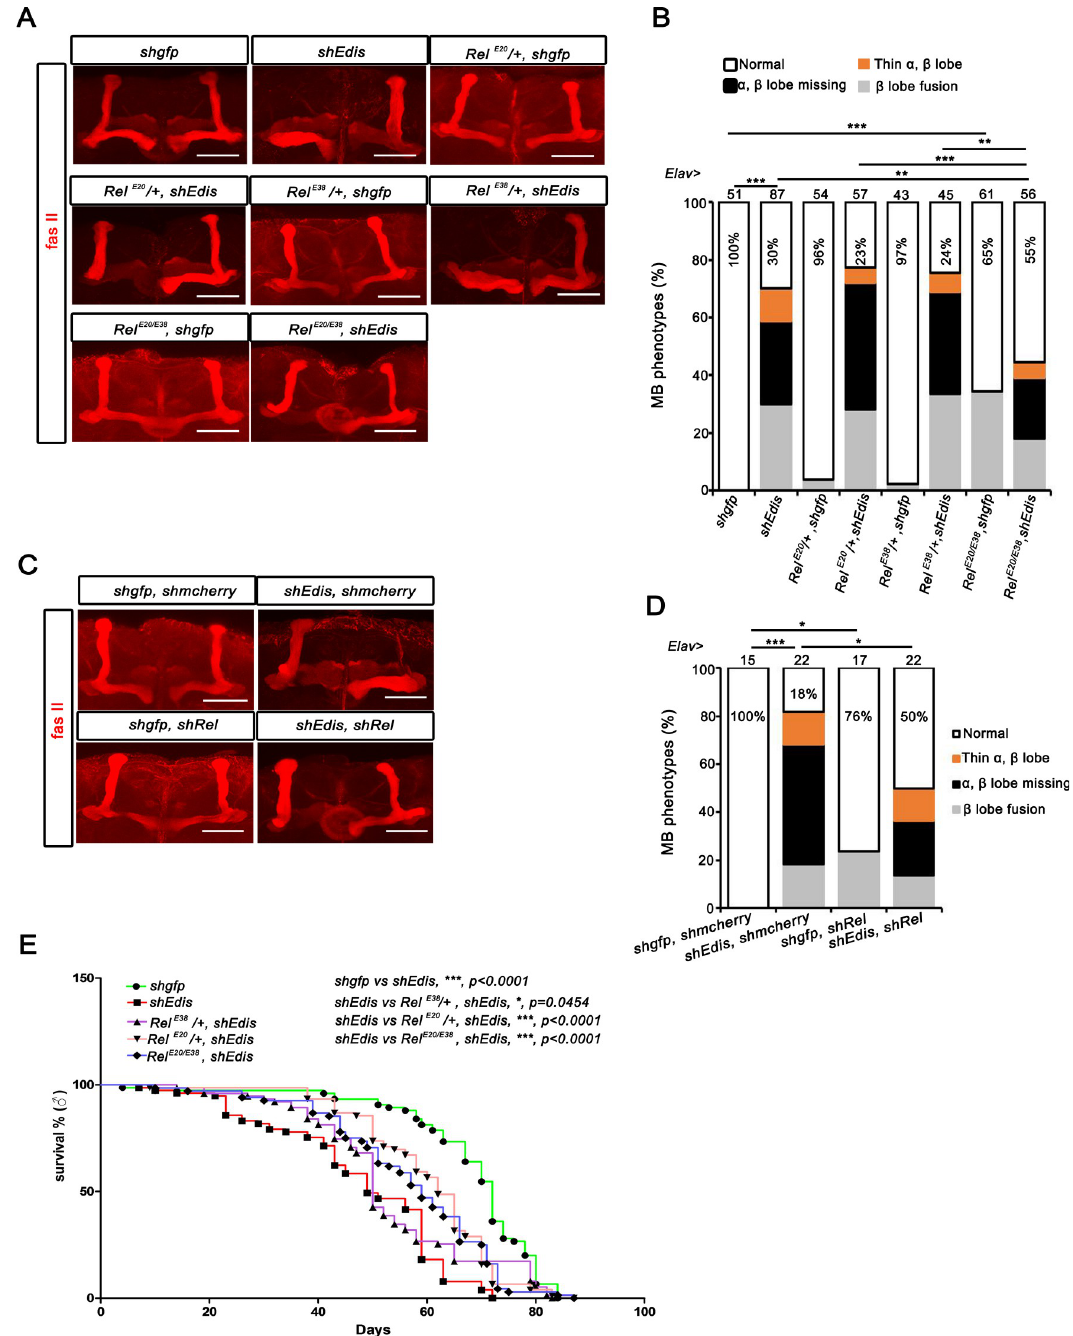
Fig 3. Neuronal phenotypes elicited by Edis depletion depend on Relish. ( A ) Confocal images of dorsal anterior regions of adult brains with various MB morphology phenotypes. Depletion of Edis in neurons resulted in a spectrum of severe morphological defects in the MBs as noted above each panel. The scale bar indicates 50 μ m. ( B ) MB morphology phenotypes were quantified in flies with the neuron-specific expression of control shgfp or shEdis driven by the Elav-Gal4 driver in wildtype, Relish heterozygous ( Rel E20 /+ or Rel E38 /+ ) or homozygous ( Rel E20/E38 ) mutant background. Chi-squared test was employed in statistical analysis. Sample numbers and percentages of samples showing normal MB morphology in each genotype are shown. ( C-D ) MB morphology phenotypes of in flies with neuron-specific expression of various combinations of shRNA transgenes (control shgfp , shEdis and shRel ) driven by the Elav- Gal4 driver are shown in C and quantified in D . Chi-squared test was employed in statistical analysis. Sample numbers and percentages of samples showing normal MB morphology in each genotype are shown. ( E ) Lifespan of flies of select genotypes in B is